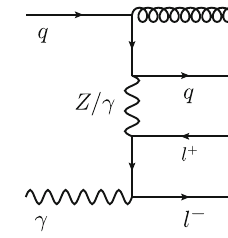
Fig. 1 An illustrative Feynman diagram from the photon induced real